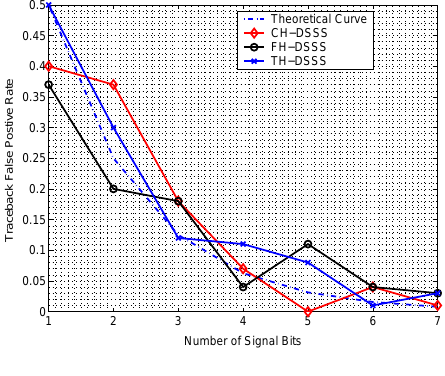
Figure 16: False Positive Rate